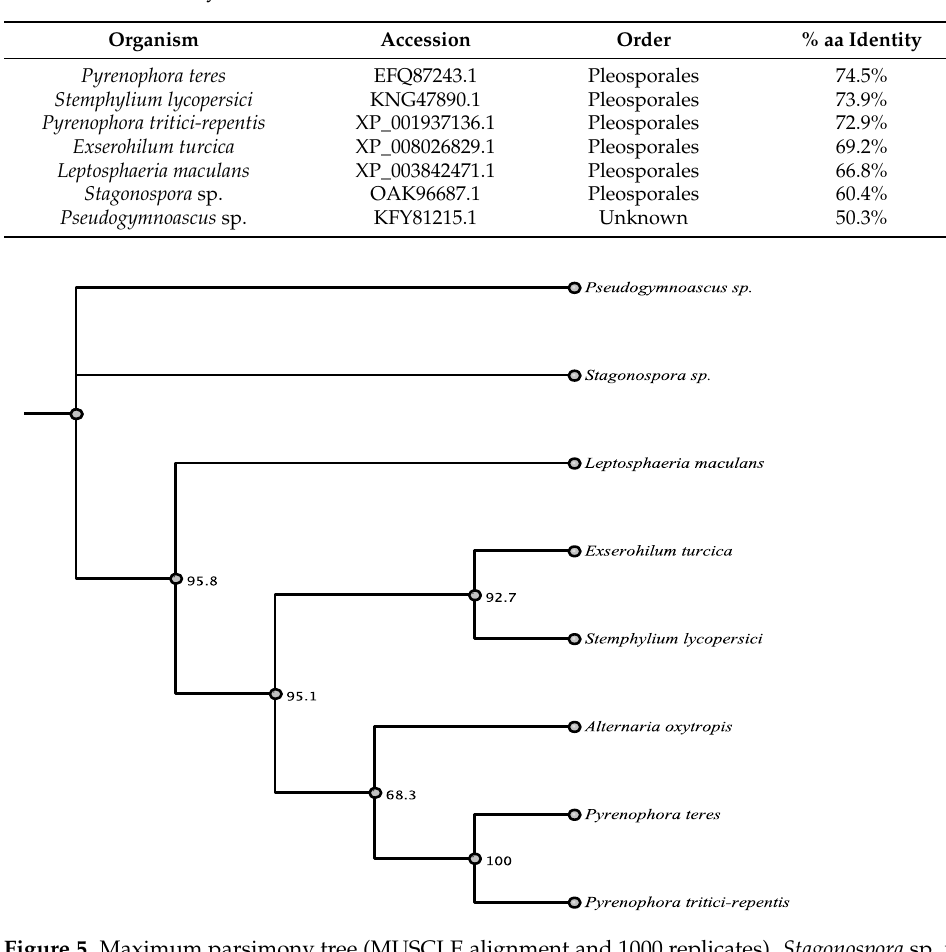
Figure 5. Maximum parsimony tree (MUSCLE alignment and 1000 replicates). Stagonospora sp. was used as the outgroup. Fungi in tree are pblast results of 39849 sequence.